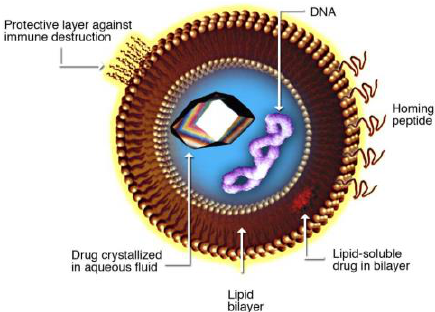
Figure 1. Schematic of liposome.